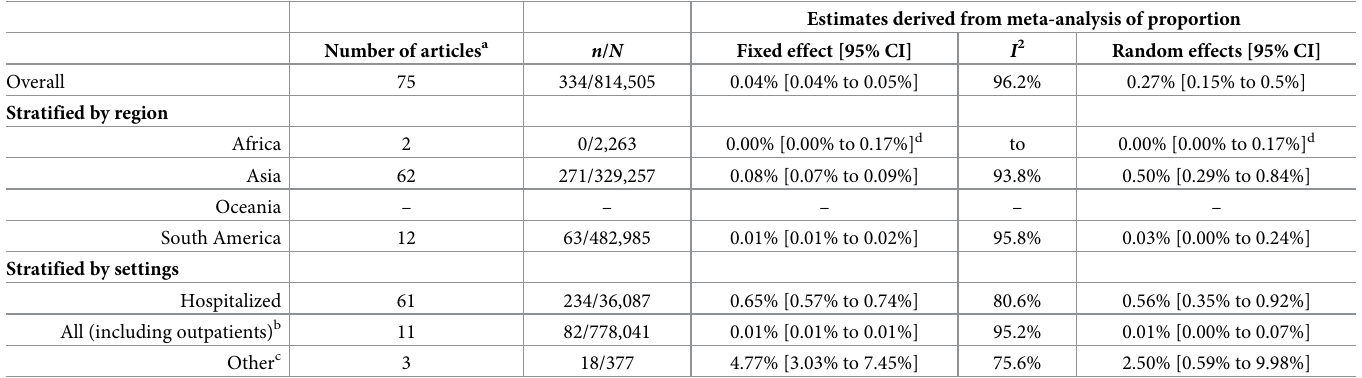
Table 4. Estimating mortality in studies eligible for inclusion in the meta-analysis.